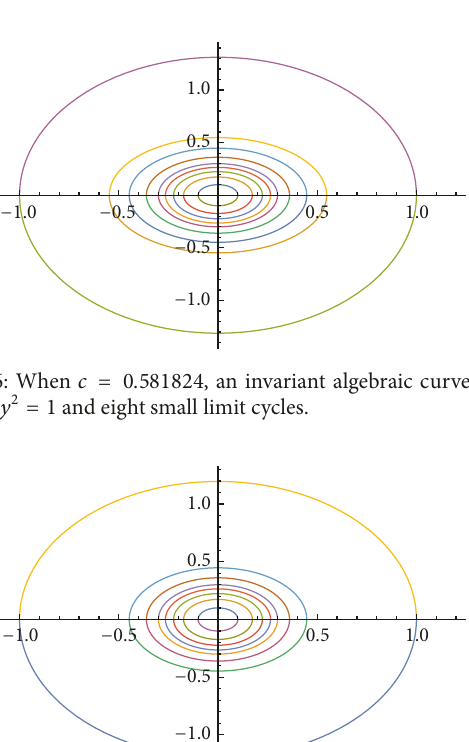
Figure 5: When 𝑐 = 0 , two invariant lines 𝑥 = ±1 and three small limit cycles.